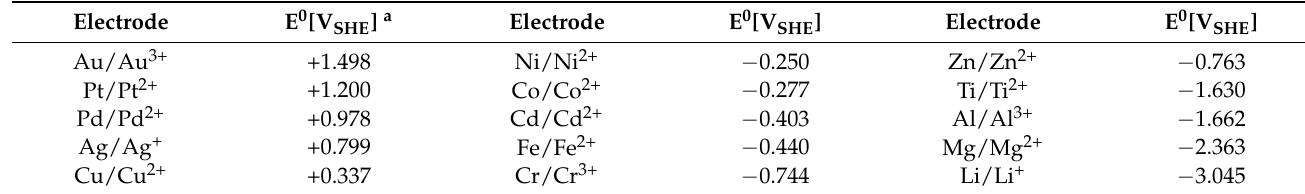
Table 2. Standard potentials, E 0 , for metal electrodes, compiled from reference [68].